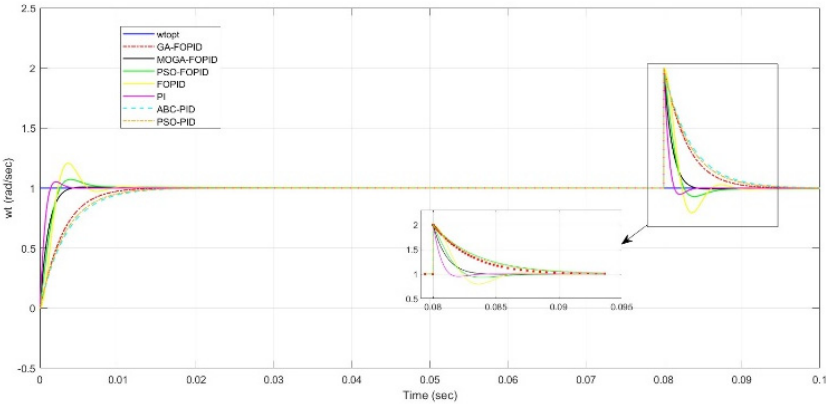
Figure 6. The behavior of the wind turbine model when a step disturbance occurred.